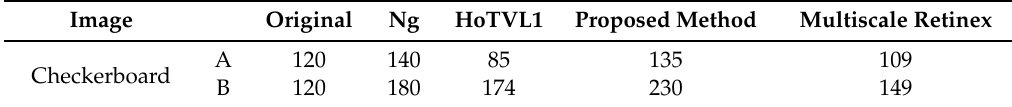
Table 3. Recovered intensity values for regions A and B of Figure 10a.